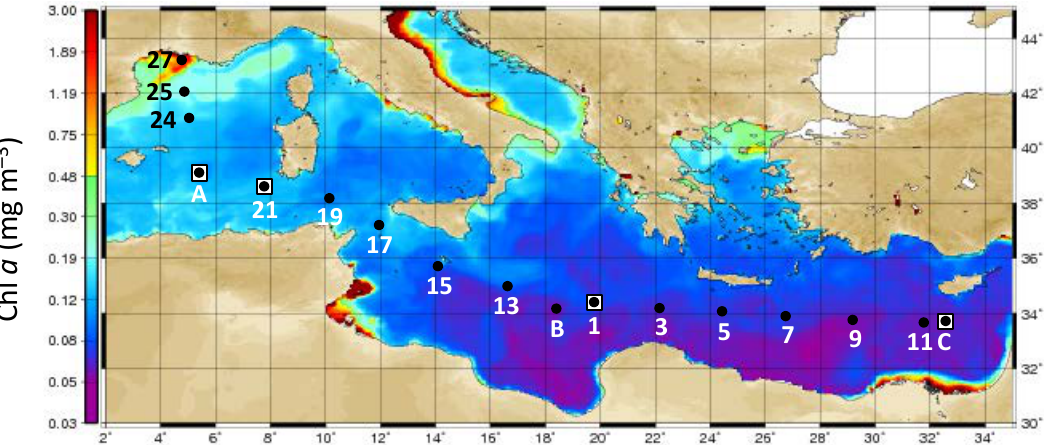
Fig. 1. Track of the BOUM cruise (16 June–20 July 2008) superimposed on the composite SeaWiFS image of the sea surface Chl- a concentrations (June 2008, courtesy to E. Bosc). Symbol types represent analyses performed at sampled stations: black spheres ( • ) indicate stations where AAP isolation was attempted and white squares ( (cid:3) ) indicate stations where RNA-based pufM libraries were additionally constructed.